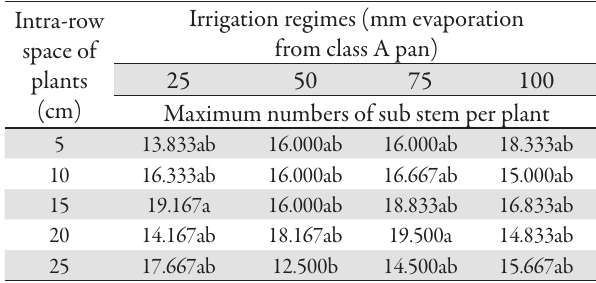
Note: The same letters show non-significant differences.